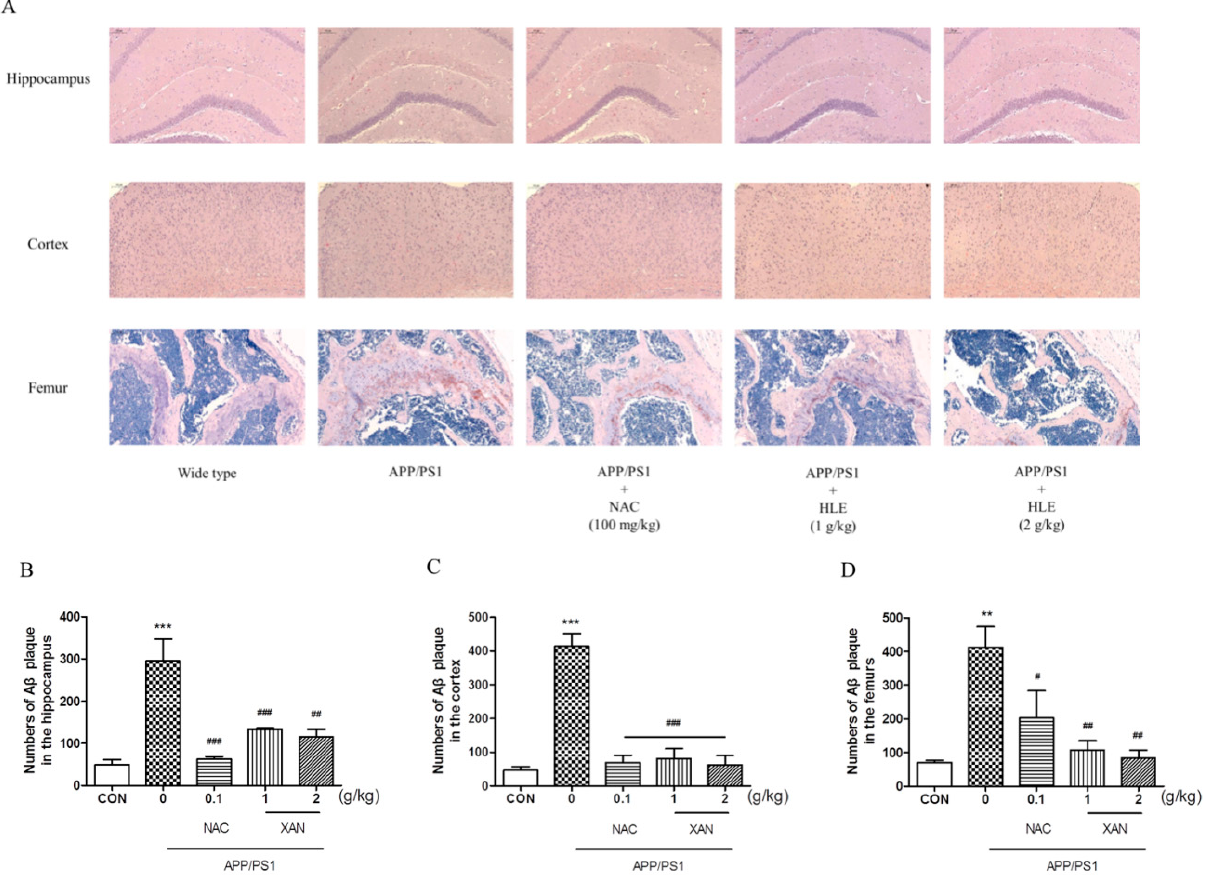
Figure 2. The effects of HLE on A β plaque in the hippocampus, cortex and femurs. ( A ) Congo red-positive plaque in the hippocampus, cortex or femurs of APP/PS1 mice; ( B – D ) quantitative analysis of amount of A β ( n = 3). (** p < 0.01, *** p < 0.001, compared with the CON group; # p < 0.05, ## p < 0.01, ### p < 0.001 compared with the APP/PS1 group.)